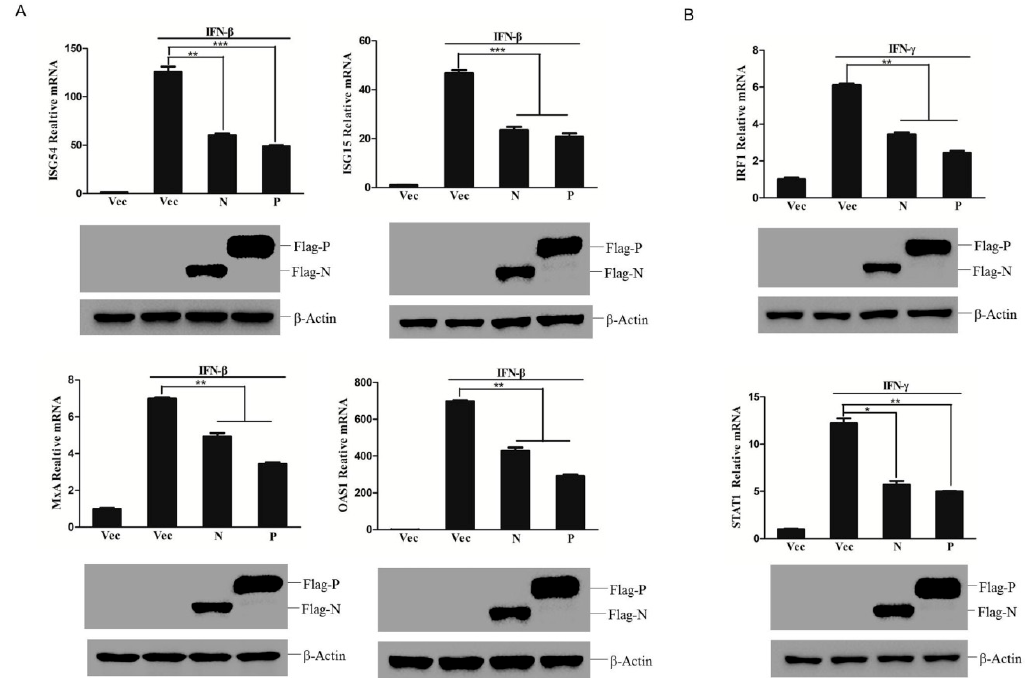
Figure 2. PPRV N and P proteins inhibited the expression of IFN- β or IFN- γ -induced antiviral genes. HEK-293T cells grown in 6 well culture plates were transfected with N protein expressing plasmids (2 μ g), P protein expressing plasmids (2 μ g) or vector plasmids (2 μ g). The cells were treated with IFN- β (1000 U/mL) ( A ) or IFN- γ (100 ng/mL) ( B ) for 12 h at 24 h post-transfection. qPCR analysis of